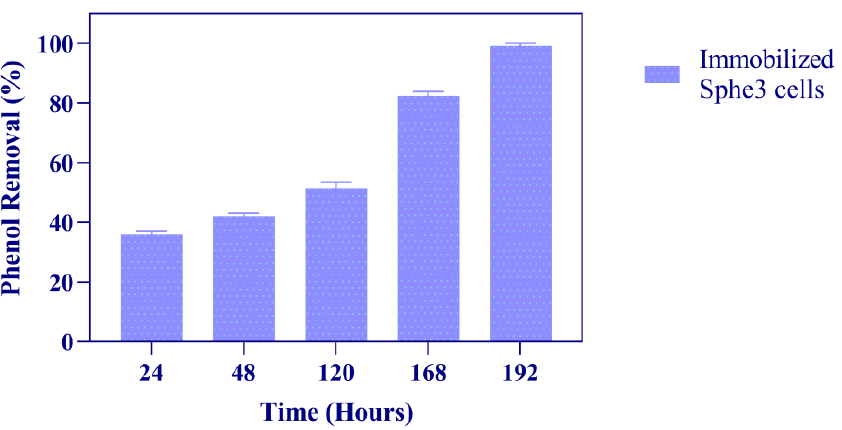
Figure 5. Phenol degradation by immobilized Ps . phenanthrenivorans Sphe3 in the presence of 1000 mg/L phenol, at 30 °C, expressed as % phenol removal activity after 24, 48, 120, 168, and 192 h. Error bars indicate standard deviation of three measurements.